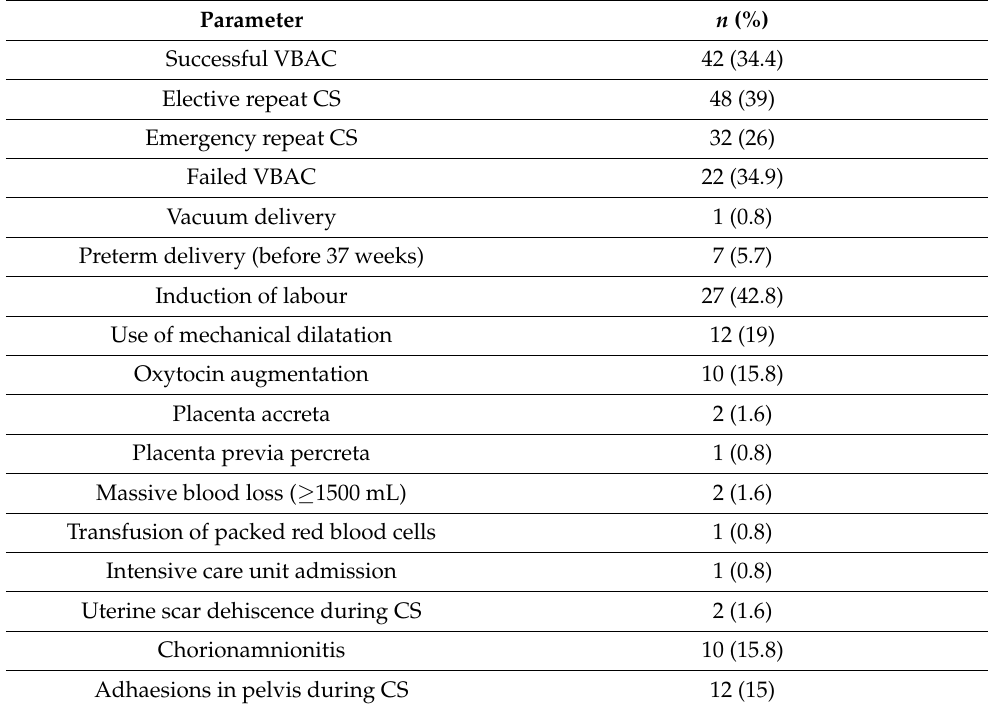
Table 1. Obstetric outcomes of the study population ( n = 122).